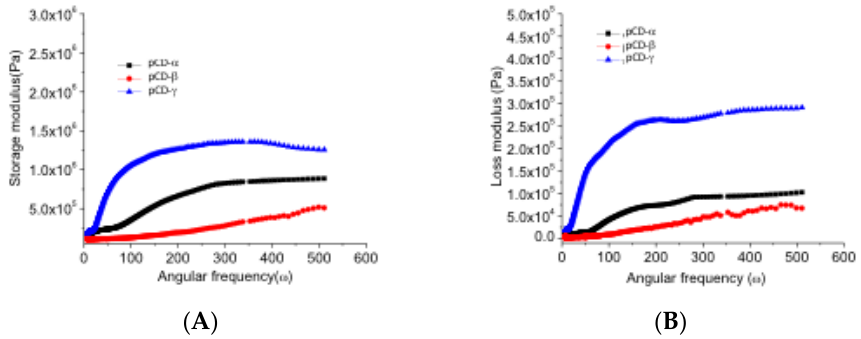
Figure 2. Frequency dependence of dynamic storage modulus (G’) ( A ), and loss modulus (G’’) ( B ) increased for all three types of pCD crosslinked at 1:0.32 according to the trend pCD- γ >> pCD- α > pCD- β . Viscoelastic properties of water swollen pCD hydrogel disks were measured using an oscillatory frequency sweep experiment at 25 °C, performed at a constant stress of 5 Pa (located in the range of linear viscoelasticity). Frequencies varied from 0.1–85 Hz plotted as angular frequency (0.6–535 radians / s). All measurements were performed in triplicate, and the presented results are the average of those